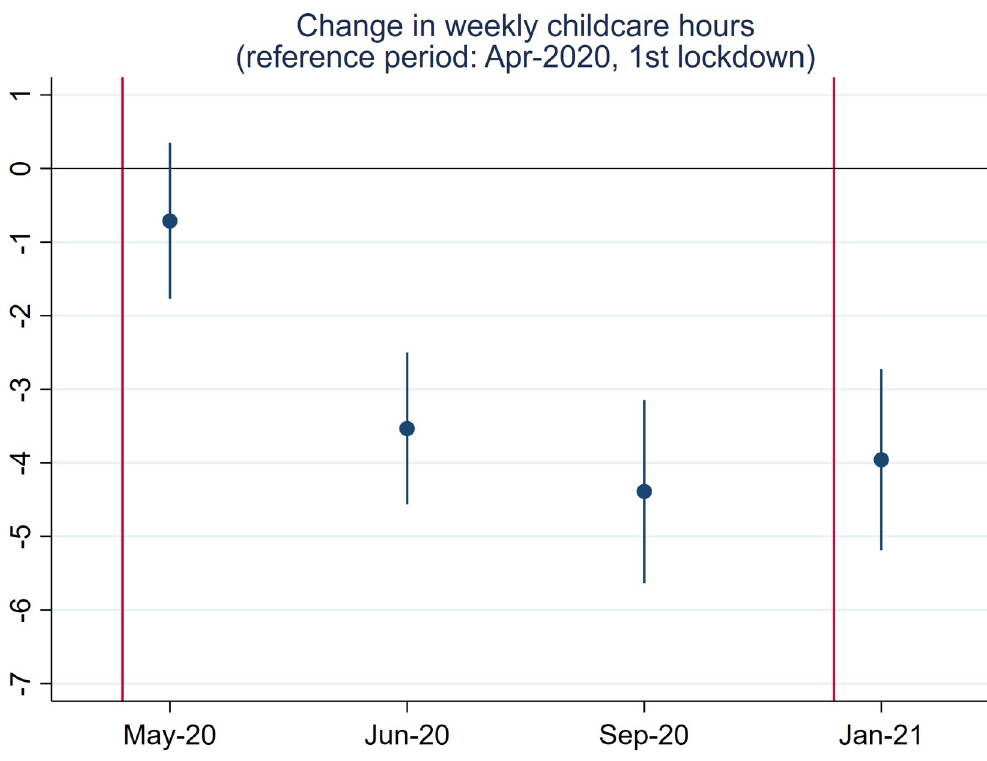
Fig 3. Point estimates and 95% confidence interval of the baseline model to predict childcare time.